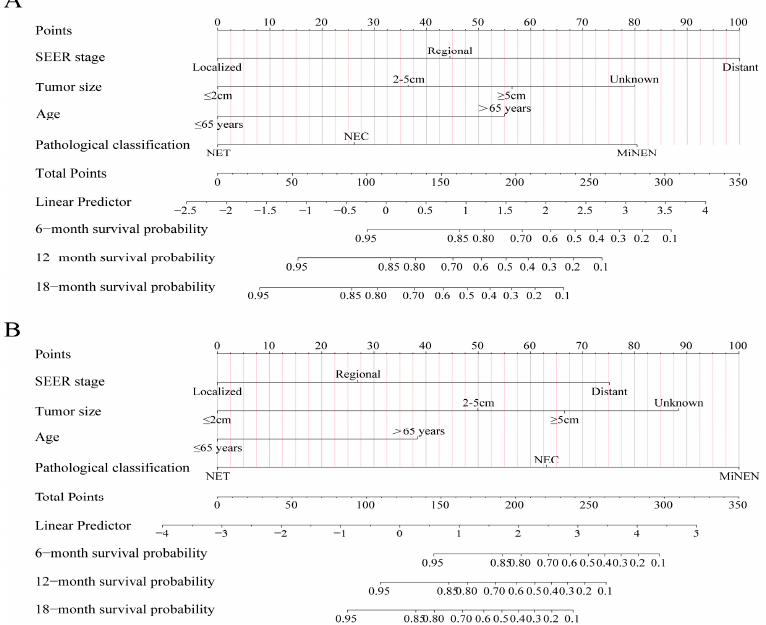
Figure 2. Predictive nomograms. ( A ) Nomogram for the prediction of 6-, 12-, and 18-month overall survival. ( B ) Nomogram for the prediction of 6-, 12-, and 18-month cancer-specific survival.